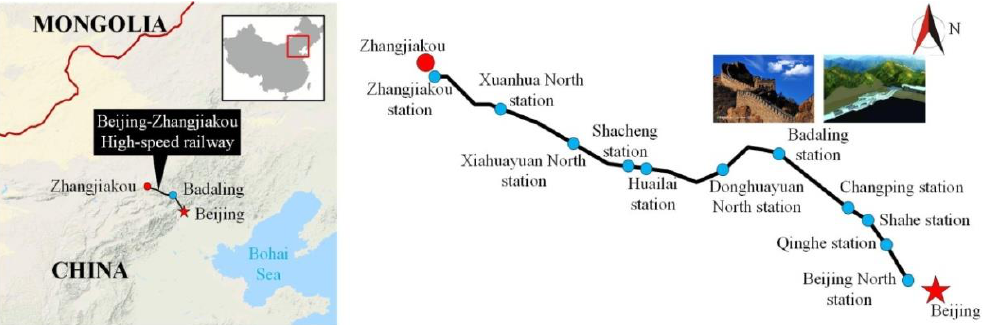
Figure 1. Map of Beijing–Zhangjiakou high–speed railway.